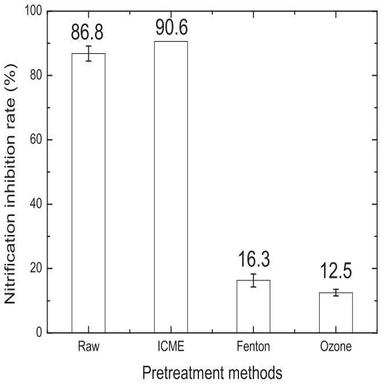
The nitrification inhibition rate of wastewater after different pretreatment.